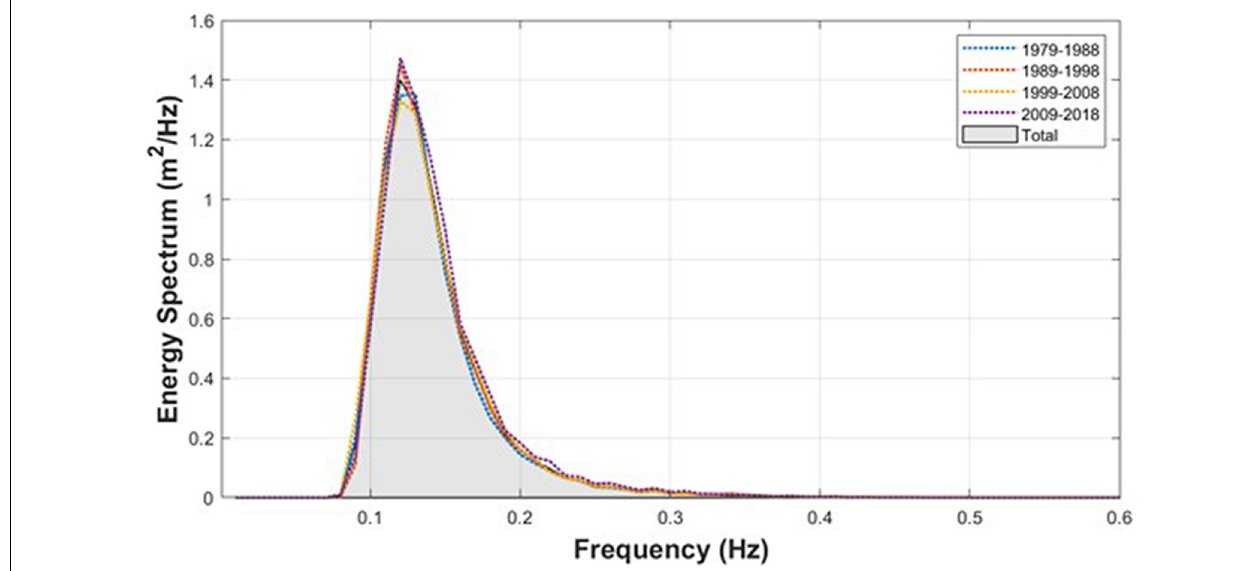
FIGURE 2 | Annual mean wave spectrum at Maengbang coast obtained from the NOAA dataset (1979–2018).